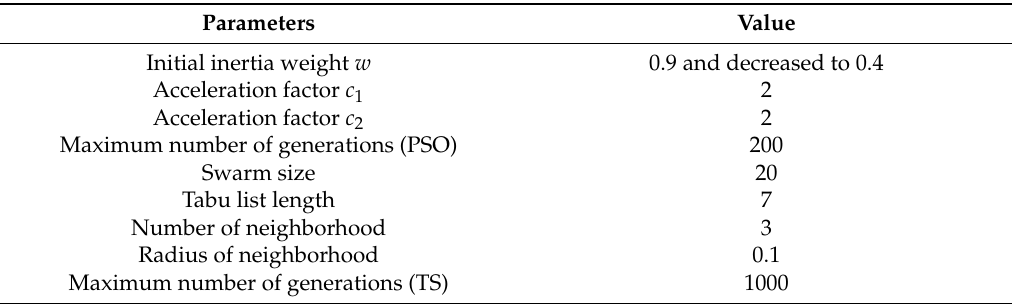
Table 1. Control parameter